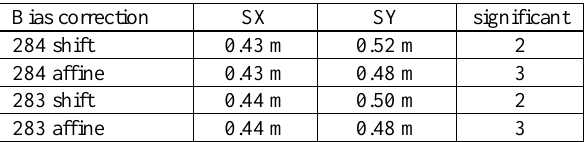
Table 3. Accuracy of bias corrected RPC-orientation at 168 GCPs and number of significant affinity